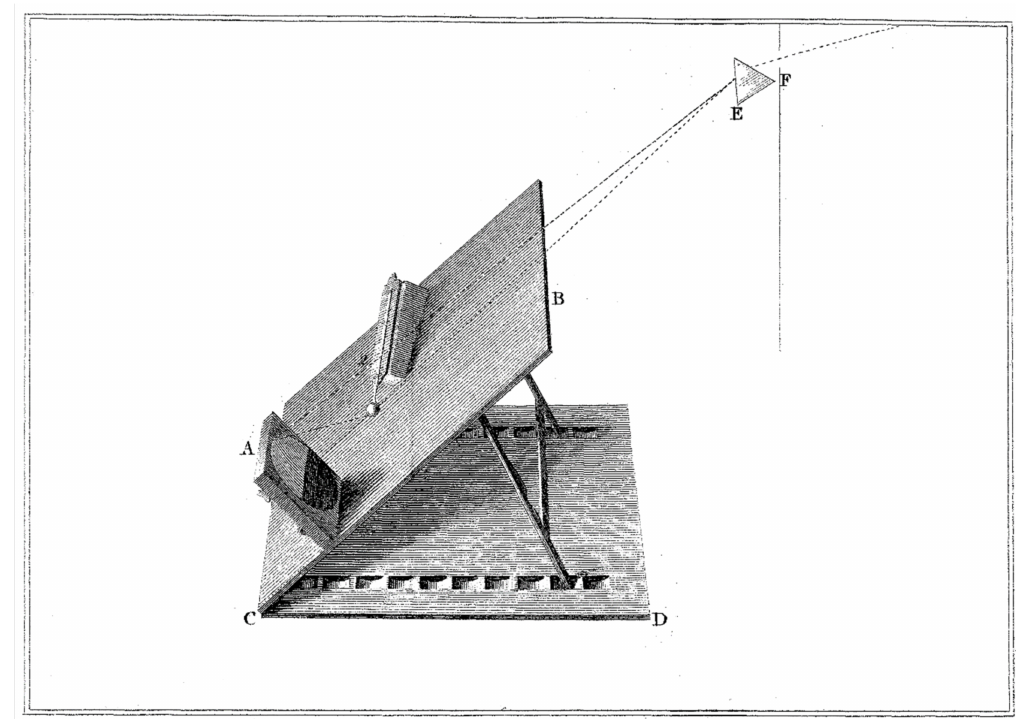
Figure 6. Measurement stand for infrared radiation focusing test—original drawing of the measurement stand [10]. A—the mirror, B, C, D—a desk adjustable to different altitudes, E—the prism receiving the sun’s rays through an opening in the window shutter F, 2—the